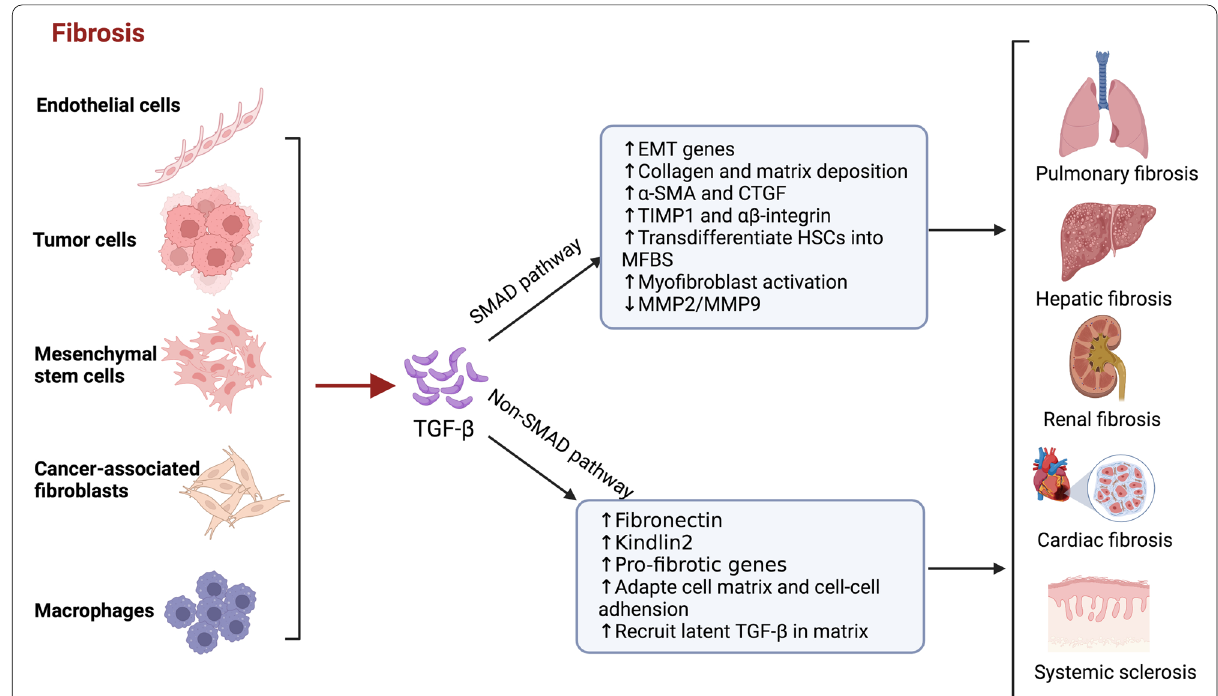
Fig. 4 The functions of TGF-β in fibrosis. Tumor cells, endothelial cells, mesenchymal stem cells, cancer-associated fibroblasts, and macrophages can induce the production and secretion of TGF-β, which induces fibrosis, including pulmonary fibrosis, hepatic fibrosis, renal fibrosis, cardiac fibrosis and systematic sclerosis, through SMAD and non-SMAD